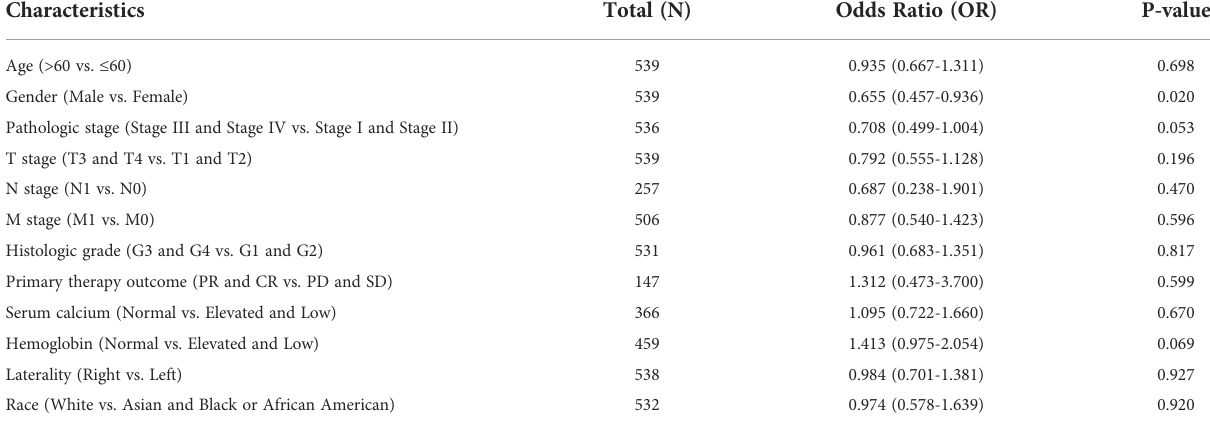
TABLE 1 ACO1 single-gene logistic